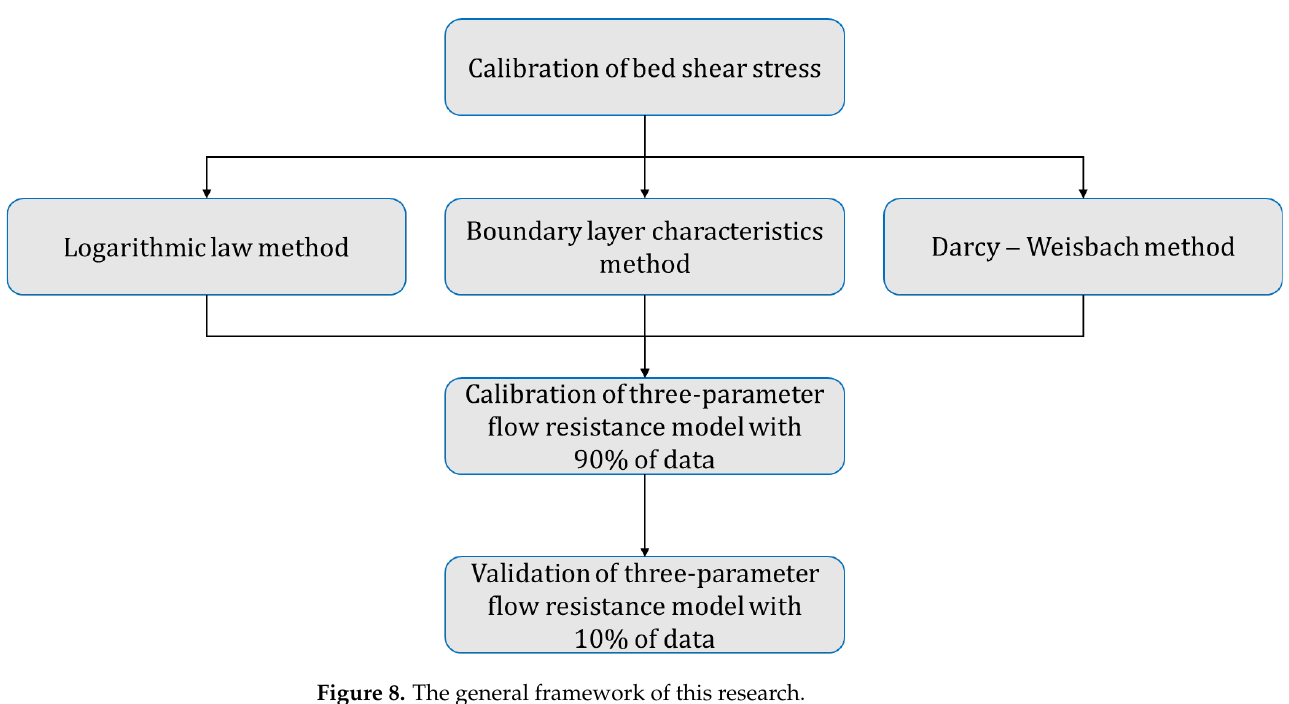
Figure 8. The general framework of this